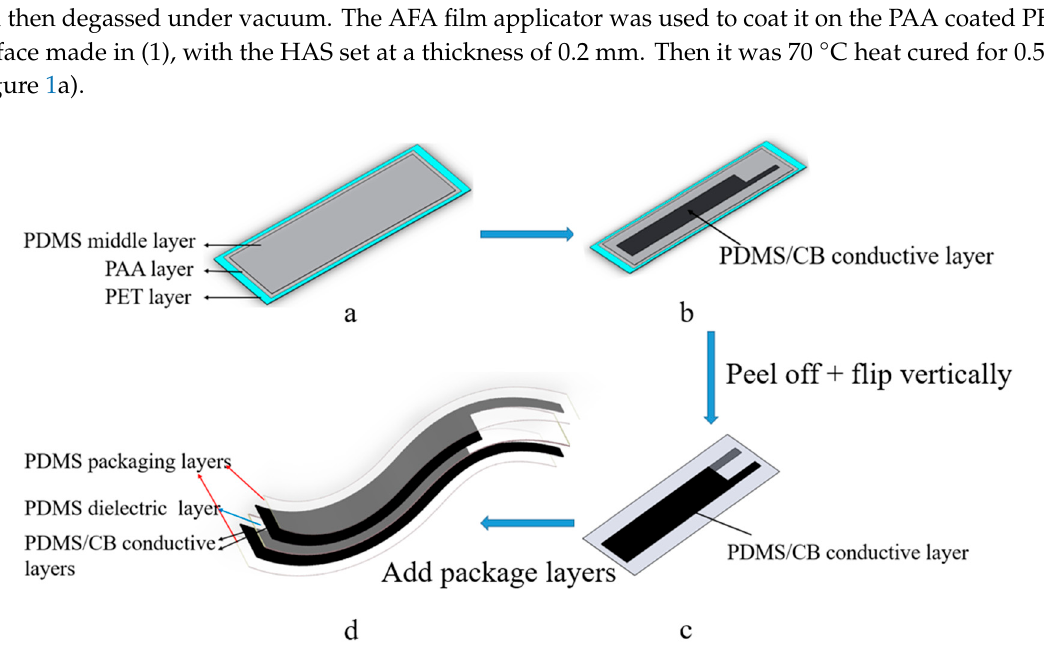
Figure 1. Schematic diagram of sensor fabrication process. ( a ) Low cost materials silicone (PDMS) coated on polyethylene terephthalate (PET) layer sprayed with poly(acrylic acid) (PAA). ( b ) PDMS/carbon black (CB) blend was coated on the PDMS dielectric layer’s surface. ( c ) Release of PDMS from PET surface with water, with PDMS/CB blend then coated on the other side of the PDMS